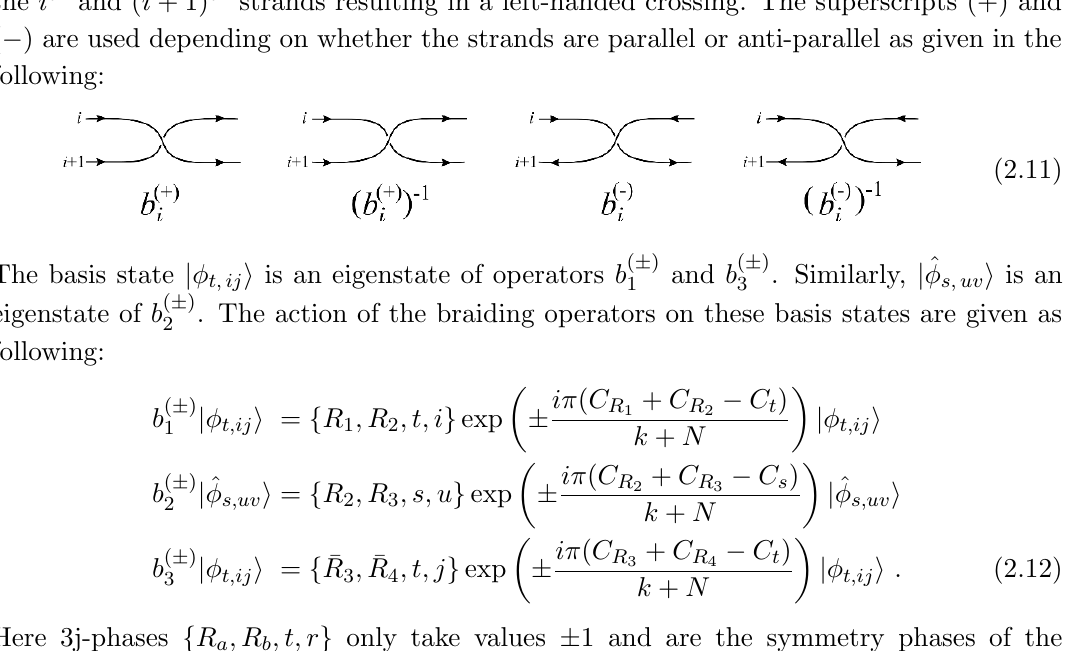
can be obtained from state α 2 | (cid:30)